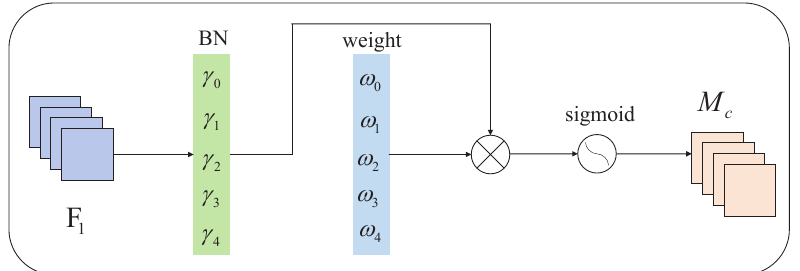
Figure 6. Channel attention submodule of NAM.